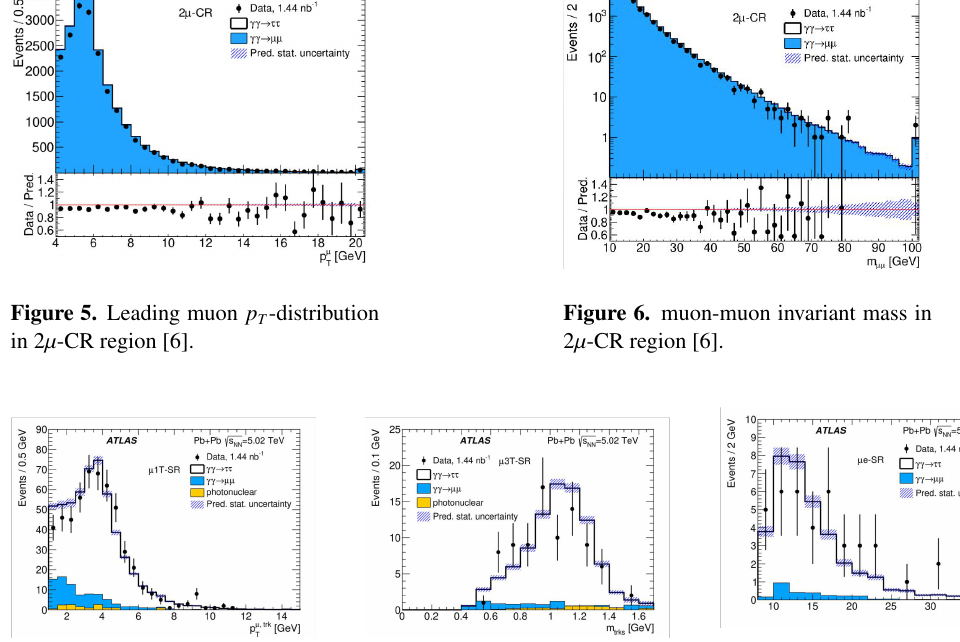
Figure 7. Signal region µ 1 T -SR: p T -distribution of µ − track (left); Signal region µ 3 T -SR: 3-tracks invariant mass distribution (central); Signal region µ e -SR: muon-electron invariant mass distribution (right)